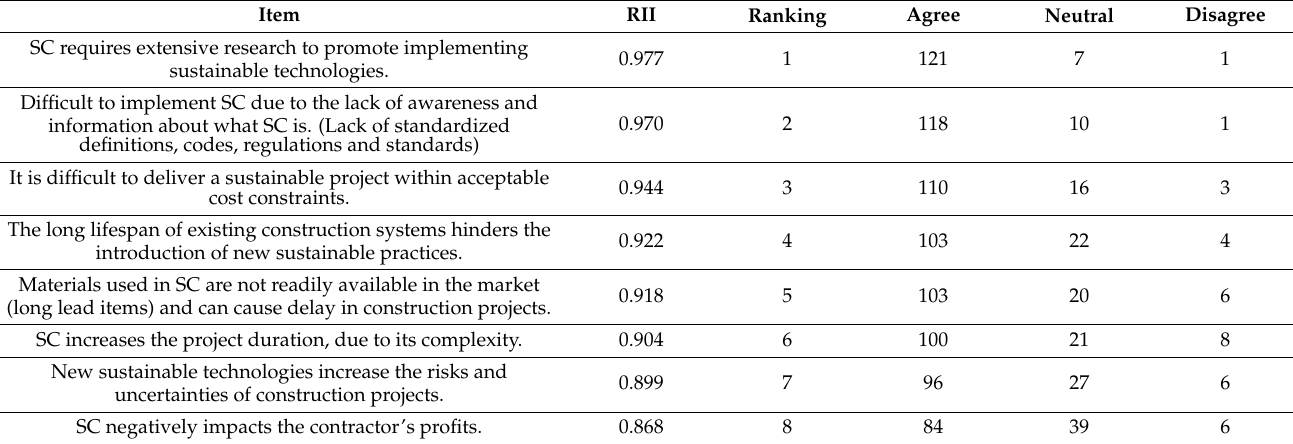
Table 17. RII ranking of the barriers associated with